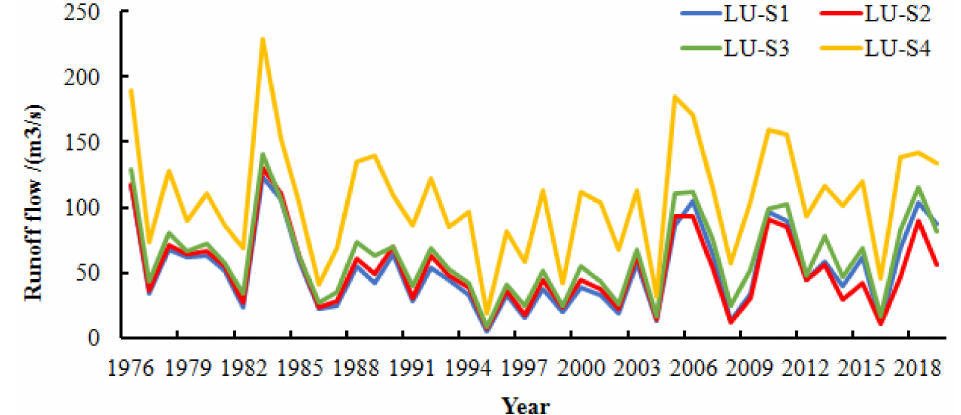
Figure 11. Comparison of simulated annual runoff trends under different land use scenarios.